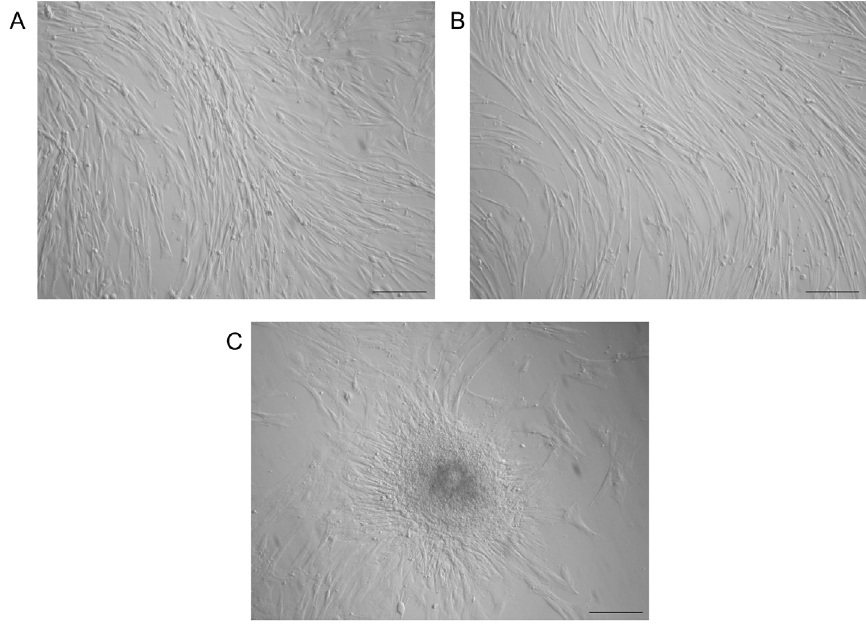
Figure 1. Cell morphology. Monolayer of AMCs (A) and EDCs (B); tridimensional cluster of AMCs (C). Magnification, x 20; scale bar =20 m